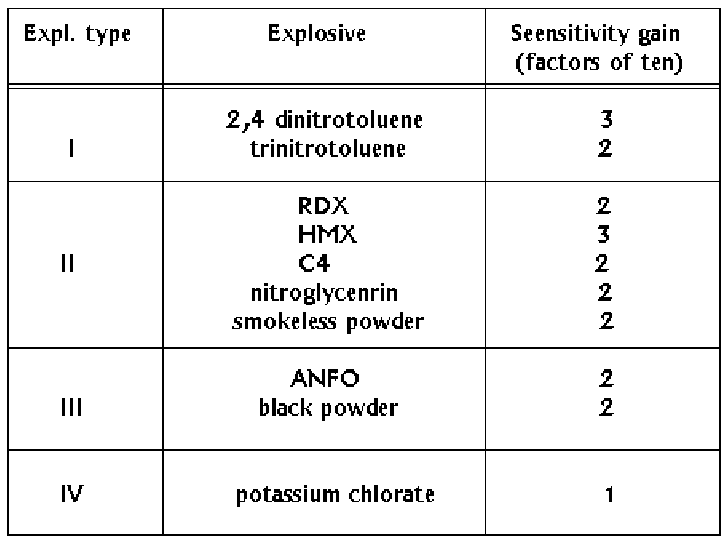
Summary of Explosives Detection Sensitivity Gain by